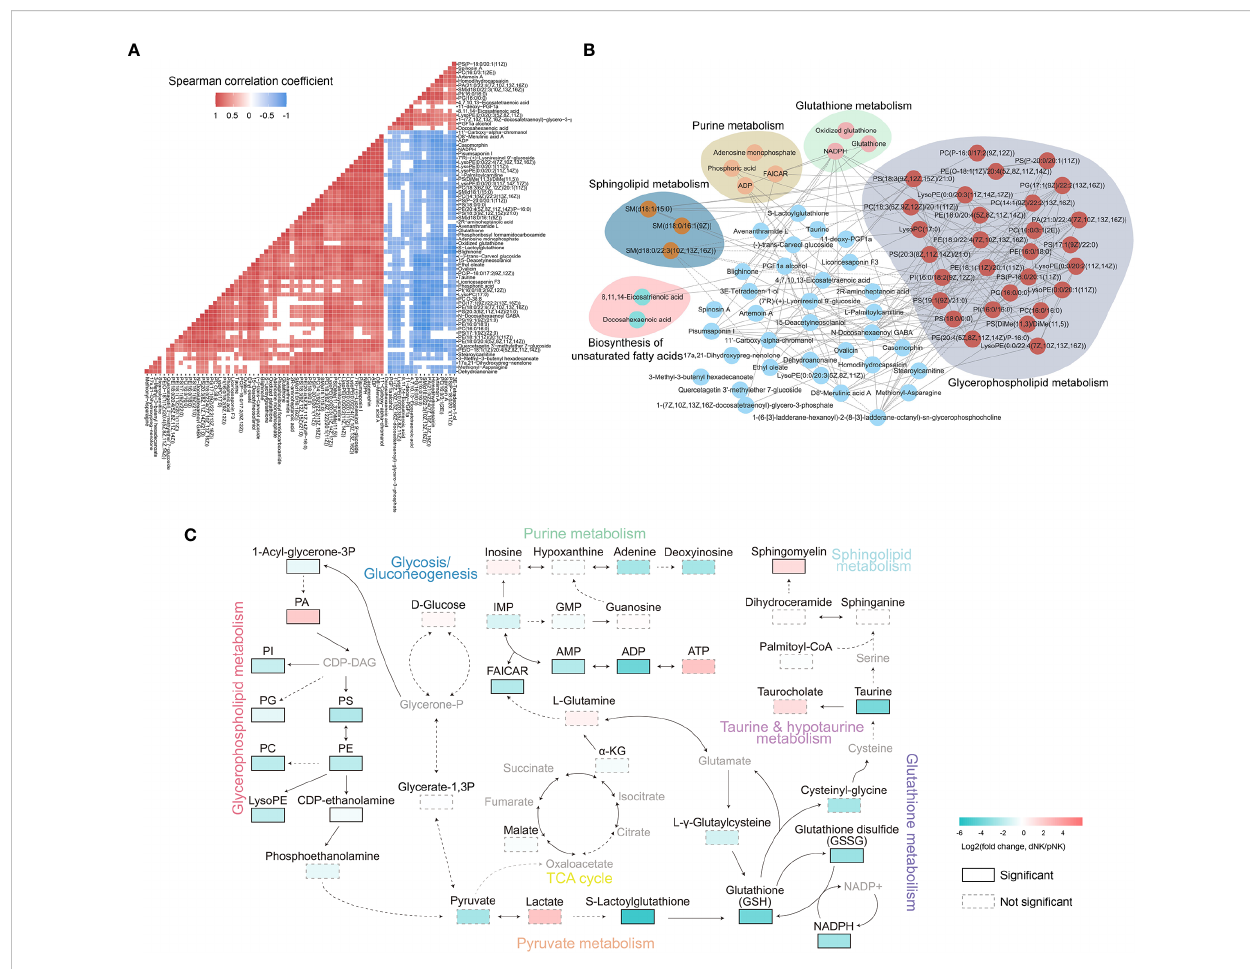
FIGURE 4 Metabolic network analysis of NK cells. (A) Heatmap of Spearman correlation coef fi cients of differential metabolites between dNK and pNK cells. Only paired metabolites with p-value < 0.05 and absolute correlation coef fi cient greater than 0.6 were colored. (B) Spearman correlation networks of differential metabolites with absolute correlation coef fi cients greater than 0.95. Solid lines represent positive correlations and dashed lines represent negative correlations. (C) Schema of metabolic pathways with select metabolites. Color corresponds to the log2 FC between dNK and pNK (ctrl) cells. Gray nodes represent metabolites that were not detected and borders are color-coded by statistical signi fi cance. CDP-DAG, Diacyl glycerol; IMP, inosine monophosphate; GMP, guanosine monophosphate; FAICAR, 1-(5 ’